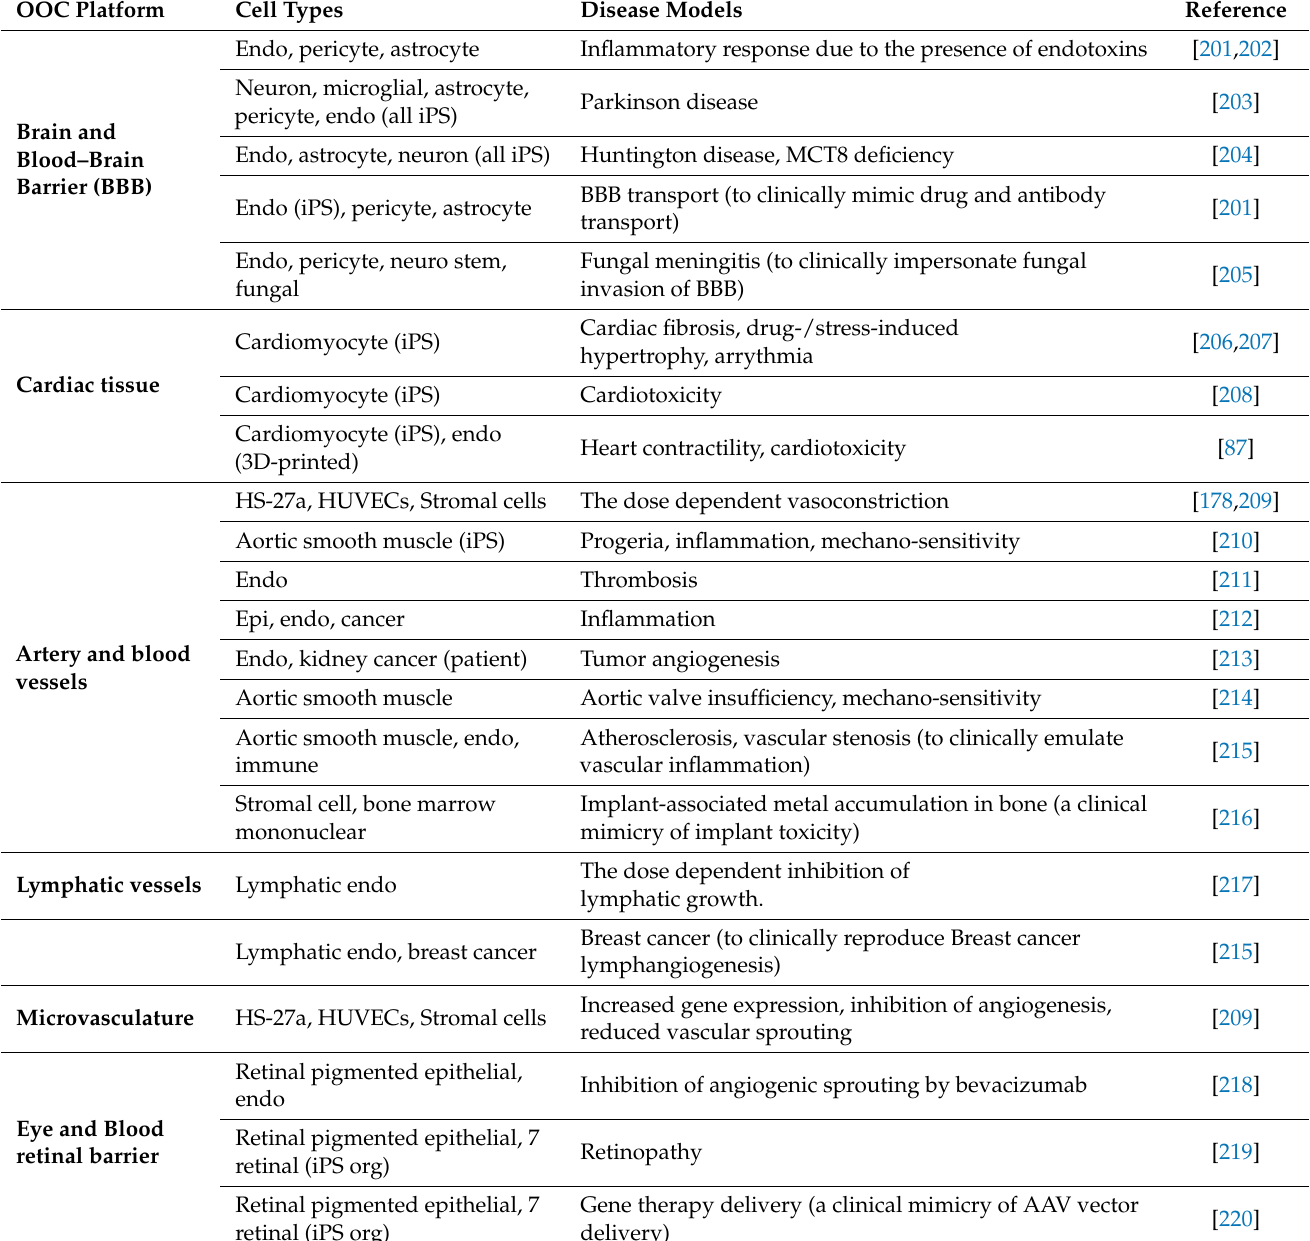
Table 3. Summary of most relevant OOC platforms, their applications and the associated disease